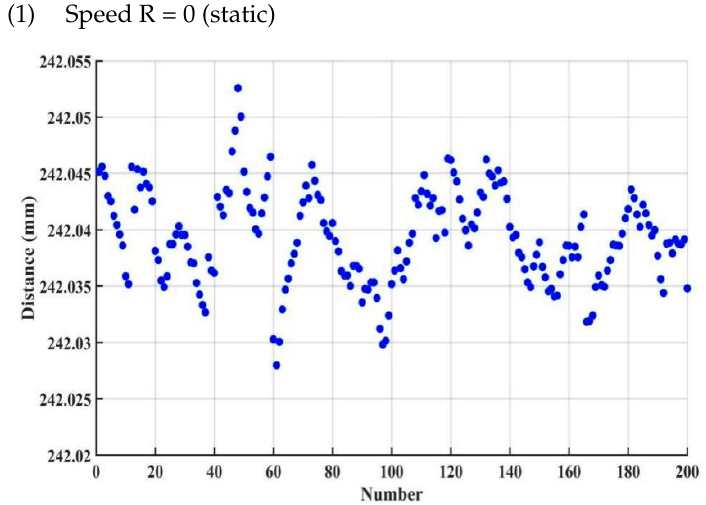
Figure 11. Measurement results of the distance between two targets in a stationary state.